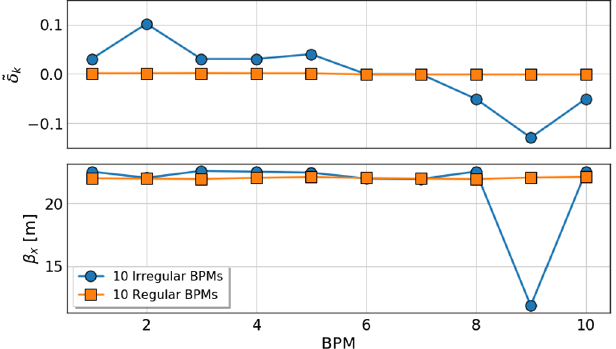
˜ δ (top) and the horizontal beta k